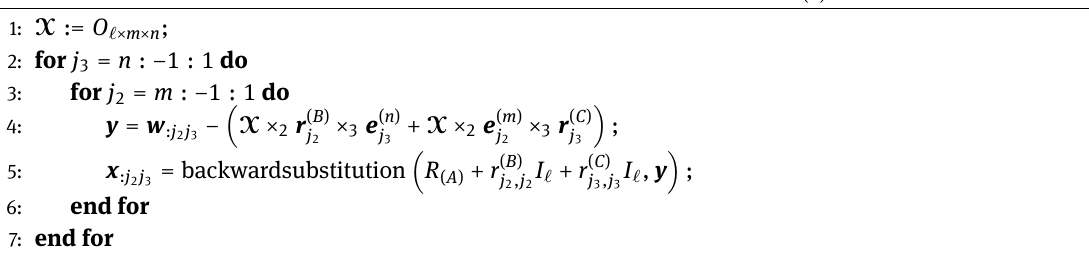
Algorithm 4-1(B) The backward substitution over tensor space for X = vec −1 ( R −1